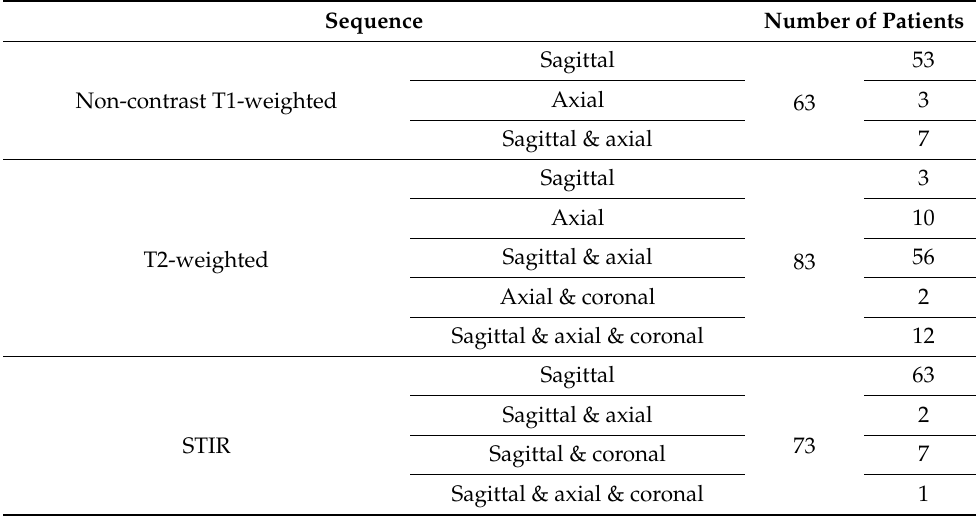
Table 1. Acquired sequences during preoperative magnetic resonance imaging